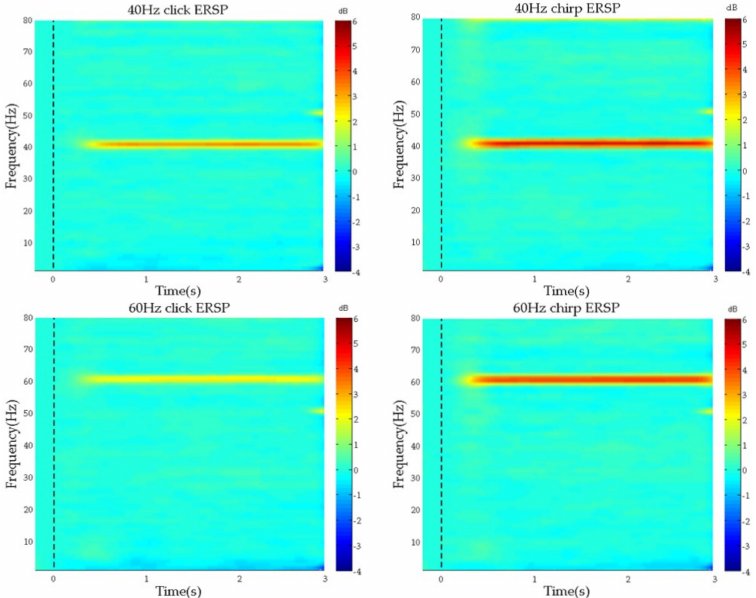
Figure 5. The event-related spectral perturbation (ERSP) averaged across all leads from 20 subjects: 40 Hz ERSP at the top and 60 Hz ERSP at the bottom. The left column represents the click stimuli and the right represents chirp stimuli. The dotted black lines represent the stimulus moment, namely the 0 time. The larger the number on the color bar, the stronger the evoked ASSRs